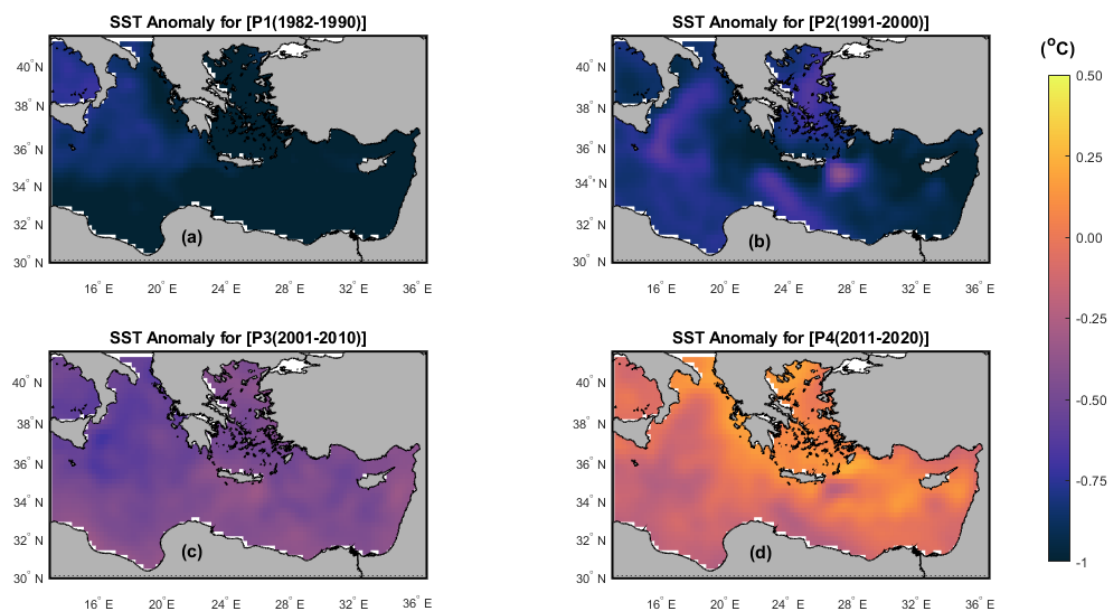
Figure 3. The EMED SST climatological anomaly maps where ( a ) P 1 (1982–1990), ( b ) P 2 (1991–2000), ( c ) P 3 (2001–2010), and ( d ) P 4 (2011–2020). Anomaly maps are calculated by subtracting the climatological mean value over (1982–2020) from each period value (P 1 , P 2 , P 3 and P 4 ) at the same location (grid).